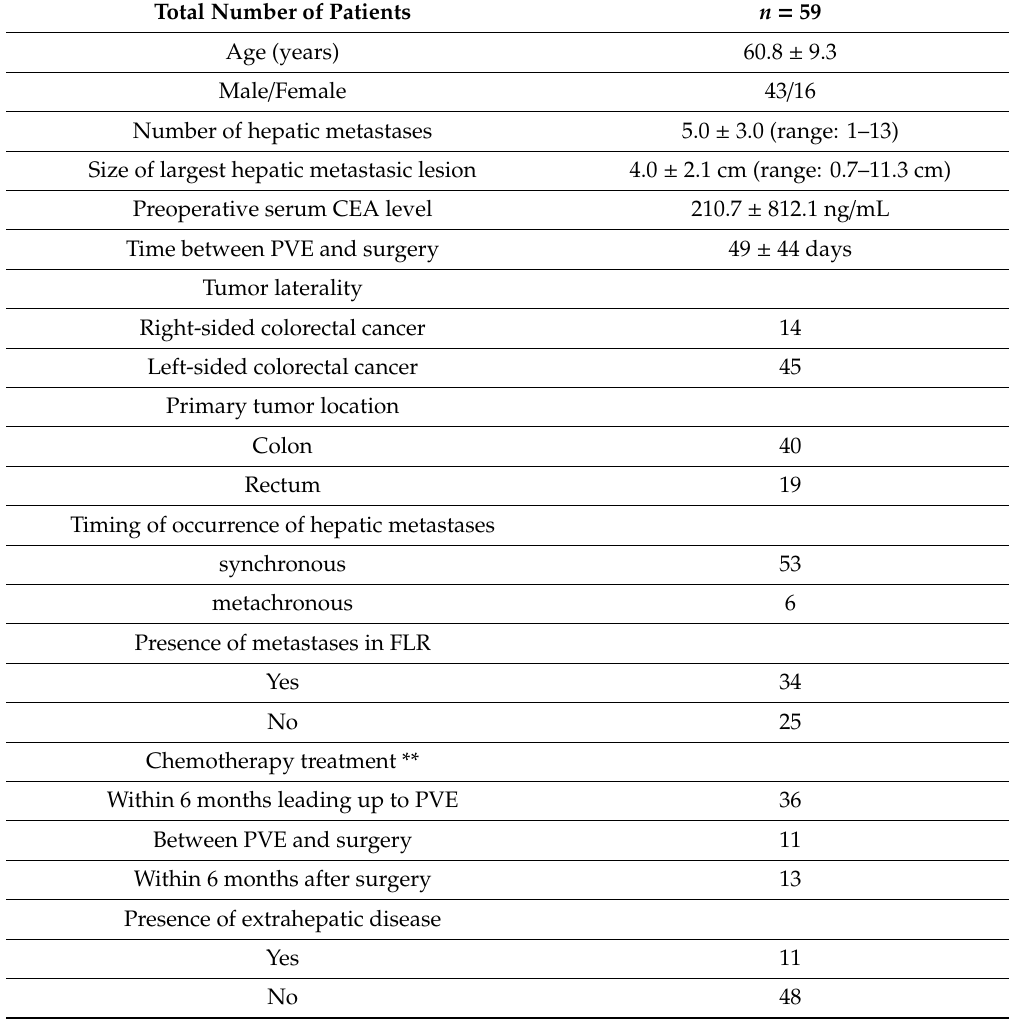
Table 1. Baseline patient characteristics. CEA: carcinoembryogenic antigen, FLR: future liver remnant, PVE: portal vein